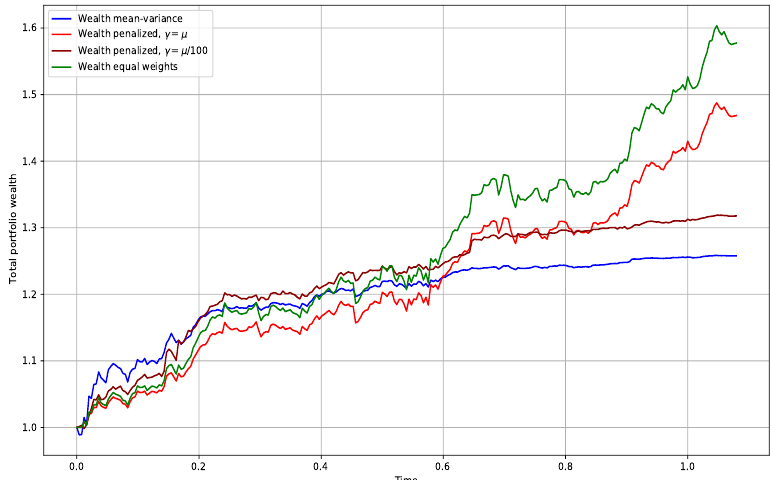
Figure 5. Sharpe ratios: Mean-variance: 0.183; Equal weights: 0.258; Penalized γ = µ : 0.260; Penalized γ = µ /100: 0.226.